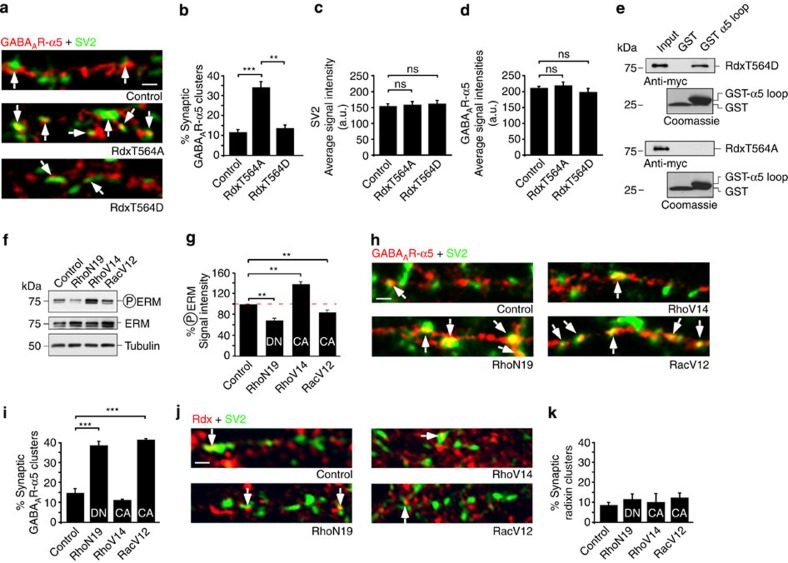
RhoA GTPase-dependent Rdx dephosphorylation increases GABAAR-α5 synaptic density.Arrows: synaptic co-localization of endogenous GABAAR-α5 or radixin (Rdx) with the pre-synaptic vesicle marker SV2. (a) Dendritic regions of neurons expressing RdxT564A or RdxT564D compared with neurons expressing control GFP. (b) RdxT564A causes significant synaptic GABAAR-α5 enrichment (34.20±5.17%; 3.06±0.42 cluster per 20 μm dendrite) compared with RdxT564D (13.78±2.84%; 1.28±0.23 cluster per 20 μm dendrite) or with control (11.66±2.53%; 1.08±0.21 cluster per 20 μm dendrite) (compare with Fig. 9) (n=3; 10–16 cells per experiment). (c,d) Signal intensities remained unchanged for SV2 (control: 152.06±6.43 a.u., RdxT564A: 156.32±8.51 a.u., RdxT564D: 159.97±8.51 a.u.) and GABAAR-α5 (control: 208.29±4.20 a.u., RdxT564A: 216.32±9.35 a.u., RdxT564D: 195.91±10.45 a.u.). (e) Glutathione S-transferase (GST) pull-down assays detect binding of RdxT564D, but no binding of RdxT564A to the GABAAR-α5 cytosolic loop. (f,g) Phosphorylated-ERM (PERM) levels following heterologous expression of constitutively active (CA) or dominant-negative (DN) Rho-GTPase mutants in HEK293 cells. RhoN19 (DN) (68.41±3.14%) and RacV12 (CA) (83.94±4.25%) decrease phosphorylation. Conversely, RhoV14 (CA) (137.54±4.76%) significantly increases phosphorylation (n=6). (h,i) Synaptic localization of GABAAR-α5 in dendrites from neurons expressing Rho-GTPase mutants. Note: decreased phosphorylation levels inversely correlate with increased GABAAR-α5 at synapses (see Fig. 2f,g) (control: 14.89±2.30%, RhoN19: 38.67±2.41%, RhoV14: 11.21±0.49%, RacV12: 41.43±0.93%) (n=3; 10–16 cells per experiment). (j,k) Synaptic localization of Rdx in dendrites from neurons expressing Rho-GTPase mutants. Quantification of Rdx immuno-reactive signals at synaptic sites reveals no significant differences on expression of RhoA GTPase mutants (control: 8.55±1.40%, RhoN19: 11.59±3.07%, RhoV14: 10.20±4.60%, RacV12: 12.29±2.45%) (n=3; 9–11 cells per experiments). Error bars, mean±s.e.m. Scale bars, 3 μm. ANOVA and the one-sample t-test against 100% were used for statistical analysis (***P<0.001; **P<0.01). NS, not significant.